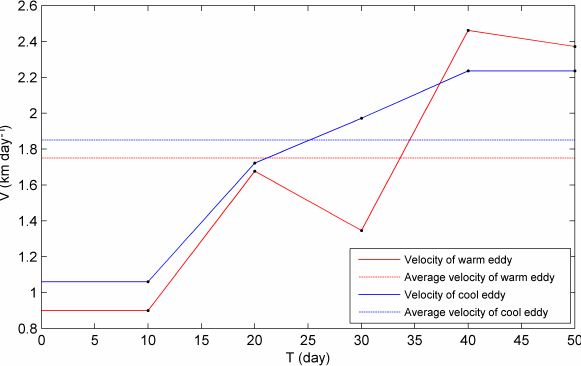
Figure 2. Eddy trajectory over a flat bottom ocean: (a) warm eddy; (b) cold eddy for 50 days. The temperature field shown in colour is a snapshot of the eddy at t = 50 days at 100m depth. The trajectory of the eddy centre is depicted by circles every 10 days.